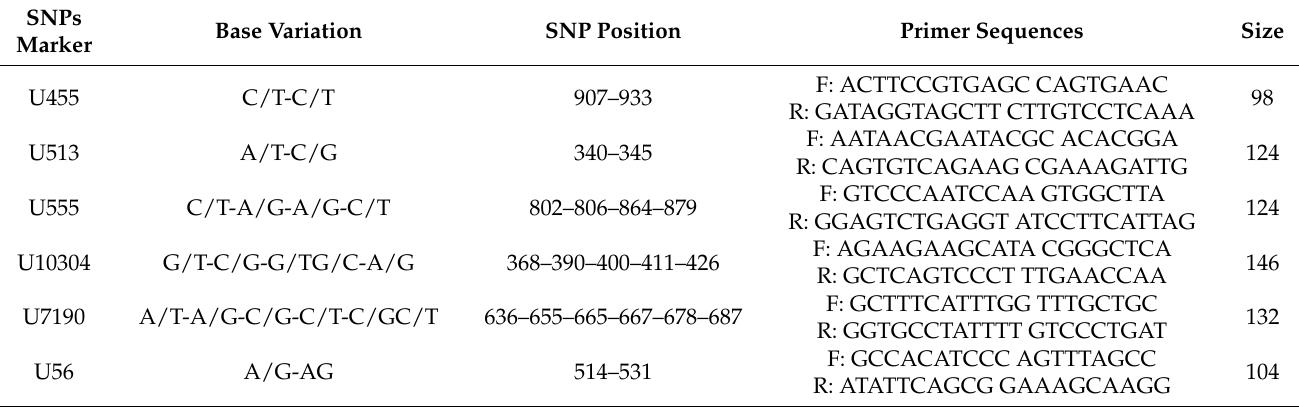
Table 3. SNPs markers used in the present work for assessing seedlings of nucellar origin